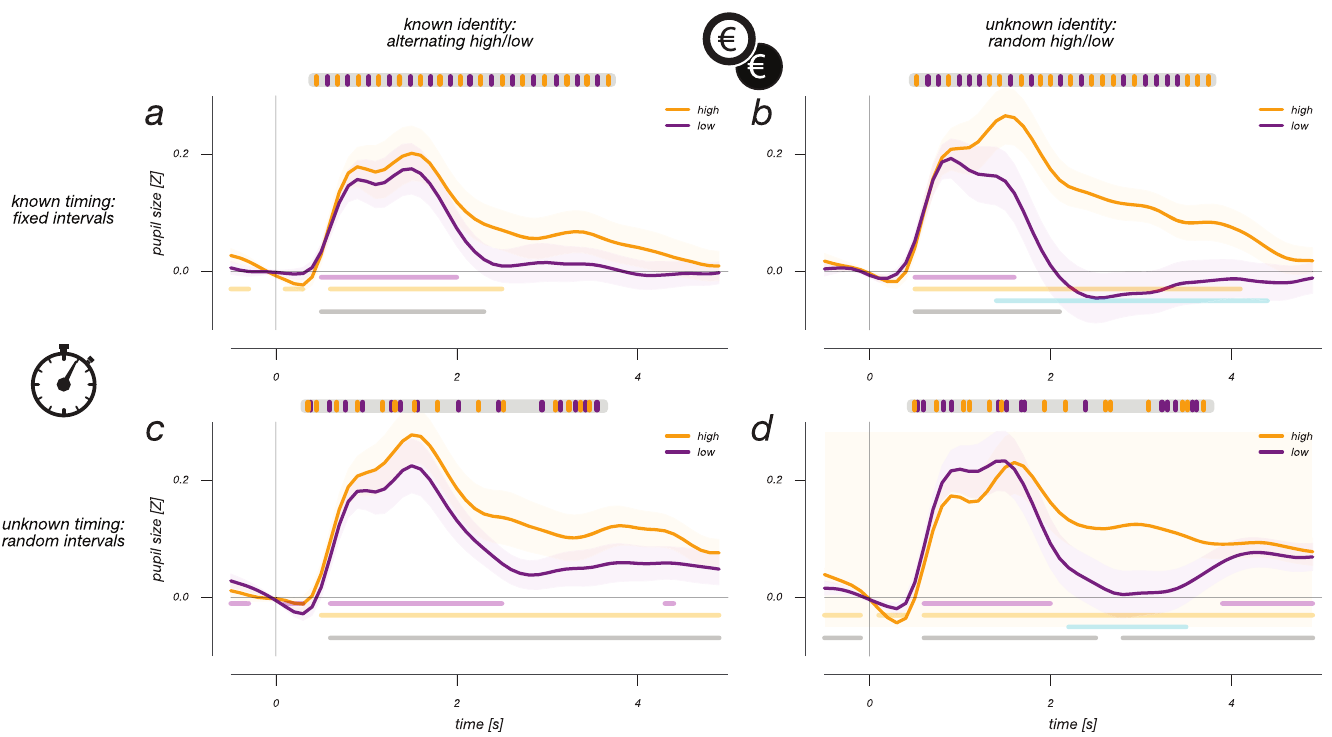
Fig 1. Finite impulse response curves for auditory events in each of the four experimental conditions. Cartoons above show, for each panel, an example time course of the occurrence of the two types of sound over time. All events elicit a transient and fast positive pupil response. Only in the conditions in which the identity of the sound was unpredictable (panels b&d), was there a difference in pupil response between the two sounds. Interestingly, this response difference occurs later in time, relative to the positive event occurrence response that all sounds share. Error regions indicate +/- standard error of the mean in all figures. Horizontal lines indicate, for each of the event types, the periods of significant difference from zero. Cyan lines indicate a significant difference between the two plotted lines, gray lines indicate significant difference between 0 and the mean of the two